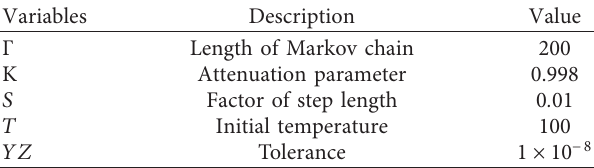
Table 2: Control parameters utilized in the